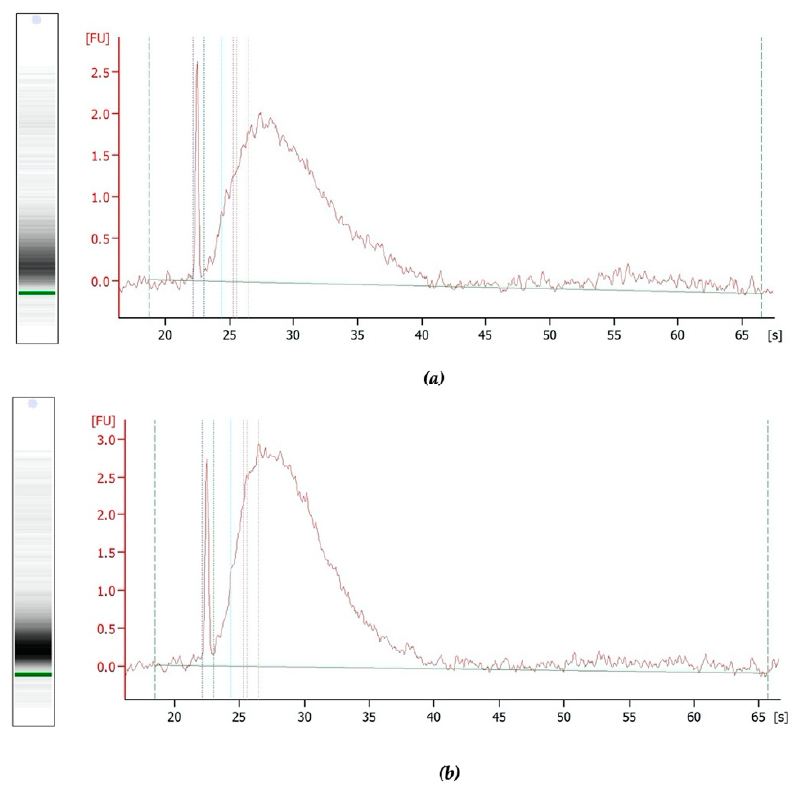
Figure A5. Output of the BioAnalyzer analysis of FFPE prostate cancer tissue ( a ) without RNA de-modification step and ( b ) with de-modification step. The image includes the gel-like image ( left side ) and the electropherogram ( right side ).